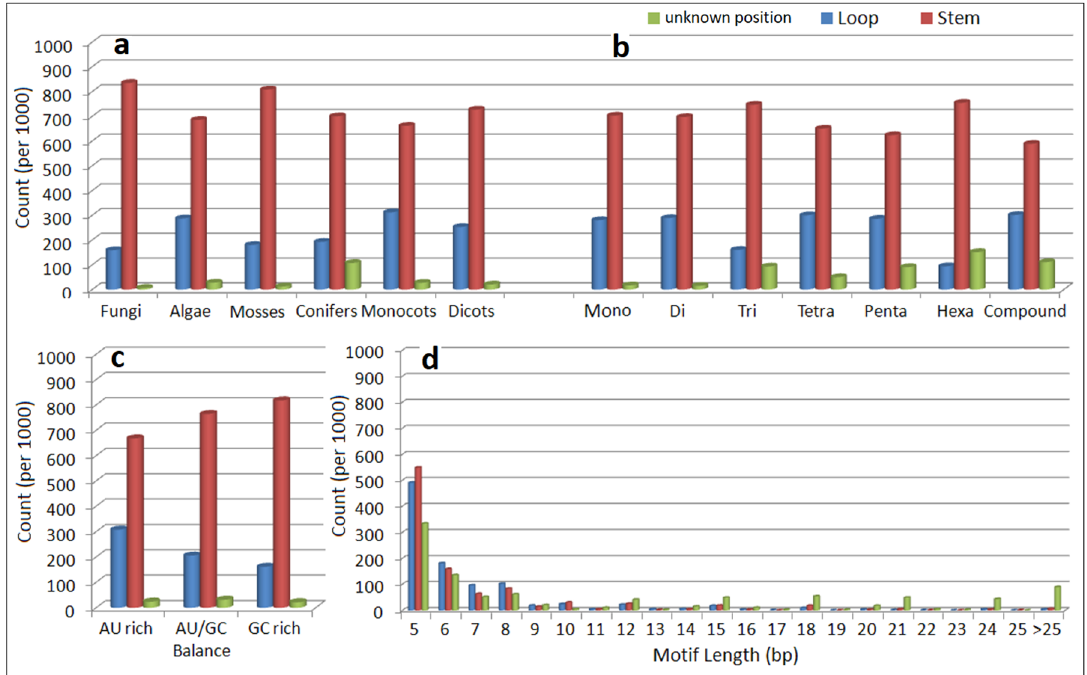
Figure 3. Locations of simple sequence repeats in stems and loops of pre-microRNA sequences. ( a ) Locations in six plant taxonomic groups; ( b ) locations of different motifs; ( c ) locations by nucleotide composition of motifs and ( d ) locations based on motif lengths.